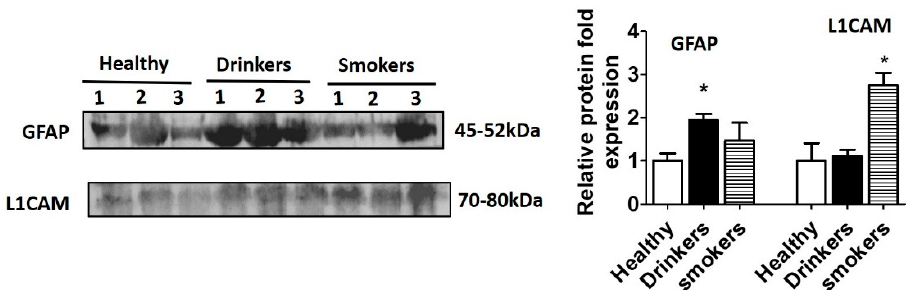
Figure 3. Expression of GFAP and L1CAM in plasma EVs of healthy subjects and substance users. EVs were isolated from plasma of Healthy ( n = 3), alcohol Drinkers ( n = 3) and cigarette smokers ( n = 3). Equal amounts of protein were loaded to analyze the expression of GFAP and L1CAM proteins in these subjects. There was a significant difference in the expression of these proteins between healthy subjects and substance users. * indicates p < 0.05 is considered significant.